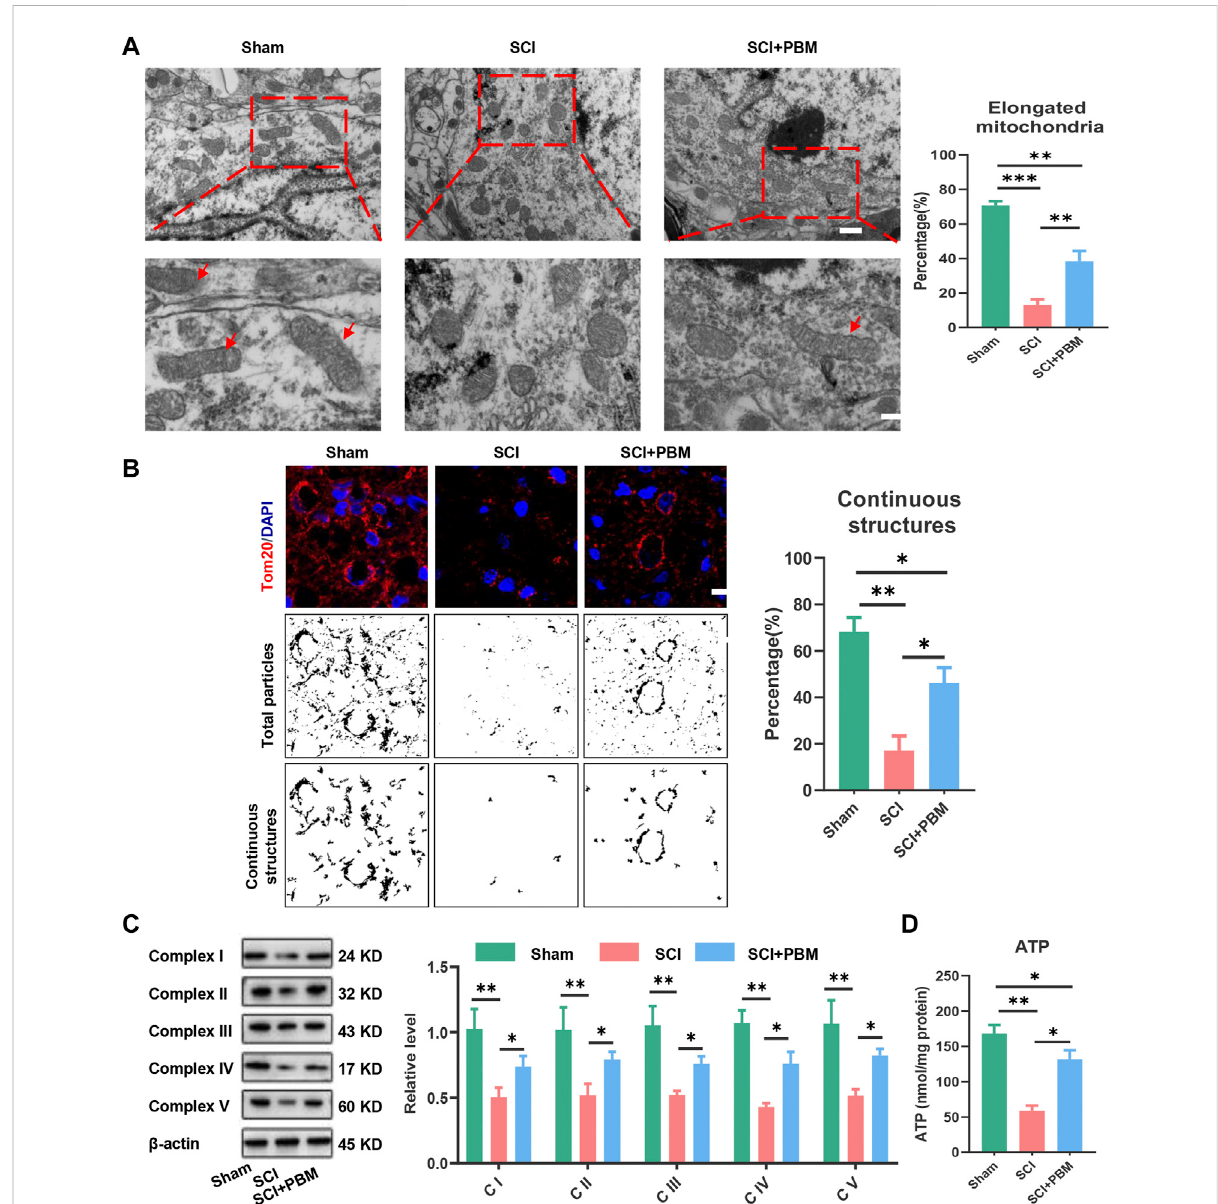
FIGURE 3 PBM promoted an increase in mitochondrial bioenergetics at 14 dpi. (A) : Representative images of neuronal mitochondria in each group by TEM. Qualitative analysis of the proportion of elongated ( > 2 μ m in size) mitochondria. Representative mitochondria are indicated by red arrows. Upper panel scale bar: 2 μ m. Lower panel scale bar: 1 μ m n = 5. (B) : Representative confocal images of mitochondria stained with Tom20 (red) at 14 dpi.NucleiwerestainedwithDAPI(blue).Imageswereseparated,thresholded, fi lteredandbinarizedwithImageJ.Continuousmitochondrial structures were calculated as the percentage of the area of large particles normalized to the total mitochondrial particles area, Scale bar: 10 µm, n = 5. (C) : Western blot analysis and quanti fi cation of the expression levels of Complex I – V in each group, n = 3. (D) : Result of ATP levels in each group, n =